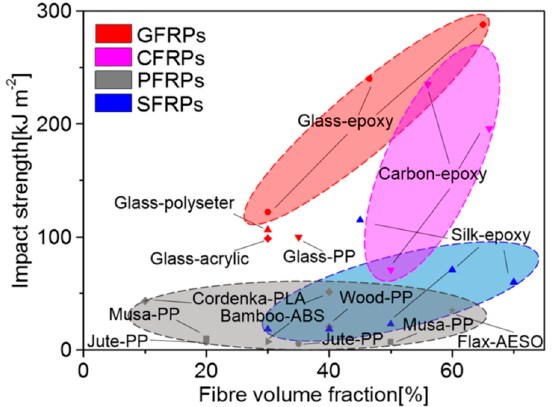
Figure 3. Comparison of the impact strength at room temperature of polymer composites reinforced by glass fibers, carbon fibers, plant fibers and silk fibers, reproduced from [71]. Note: “polyseter” is a typo of polyester.